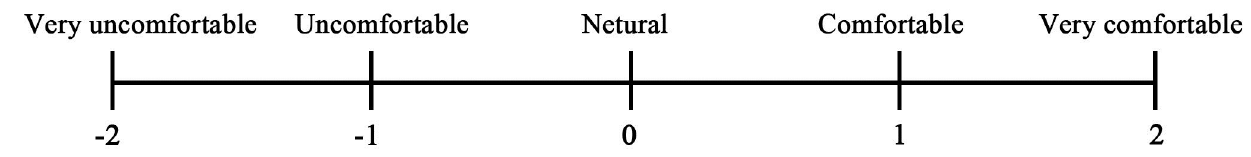
Fig 6. Thermal-comfort evaluation scales.